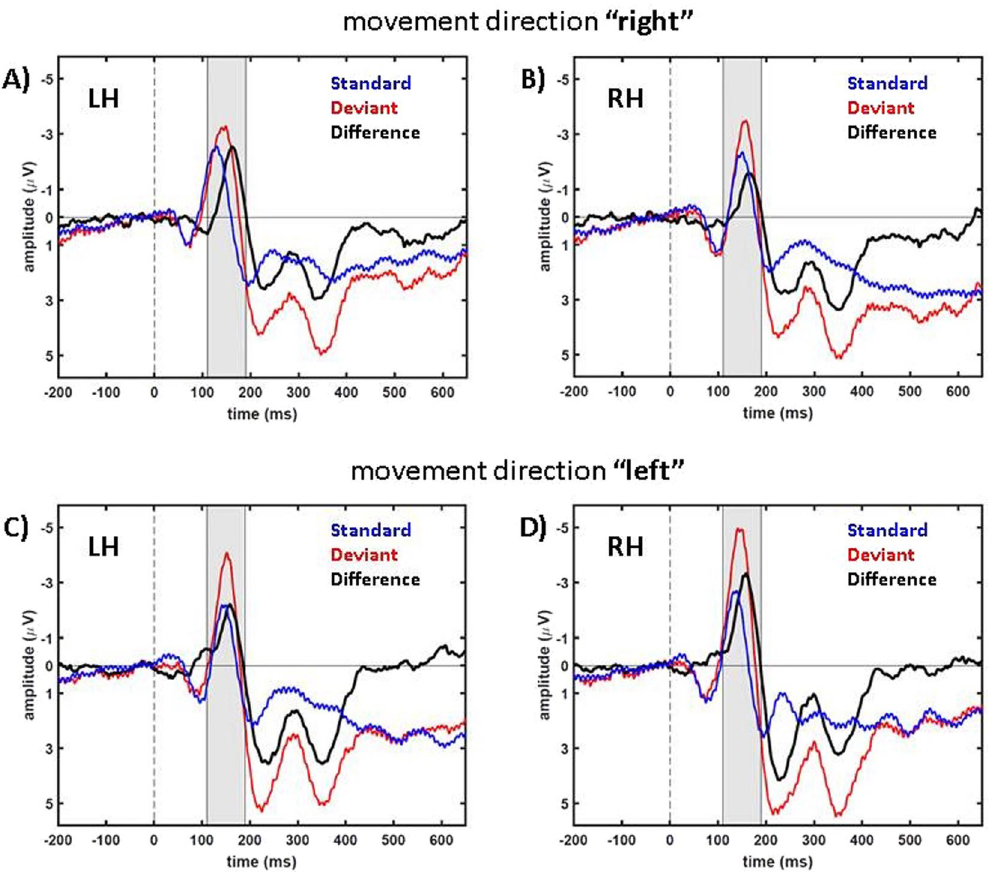
Figure 3. Population data from condition “peripheral”. In blue data of standard trials are presented, in red data of deviant trials and in black the differences (standard data subtracted from deviant data) are shown. ( A , B) show condition “right” and ( C , D ) condition “left”. In ( A , C ) data from LH is presented and in ( B , D ) data from RH.